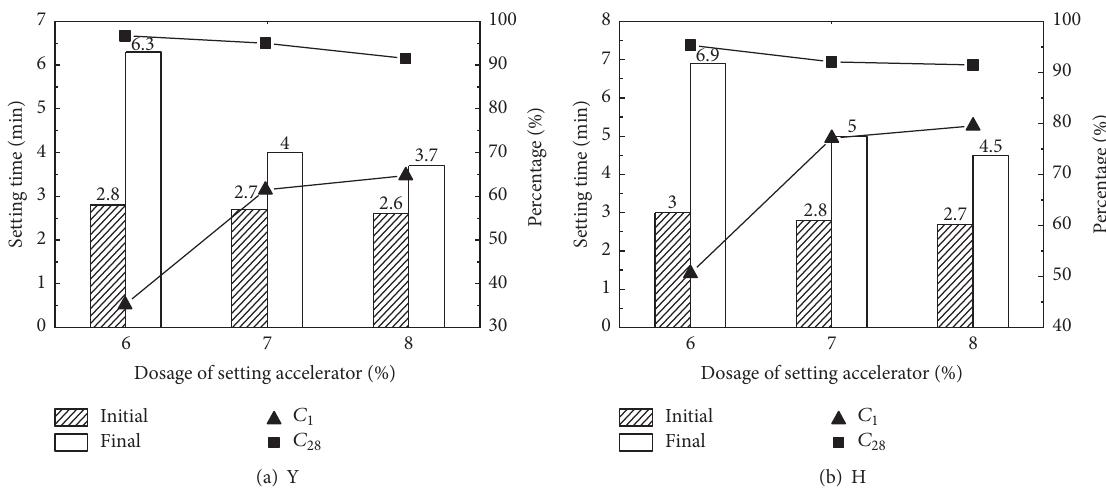
Figure 2: Effect of setting time and strength development of two kinds of cement containing